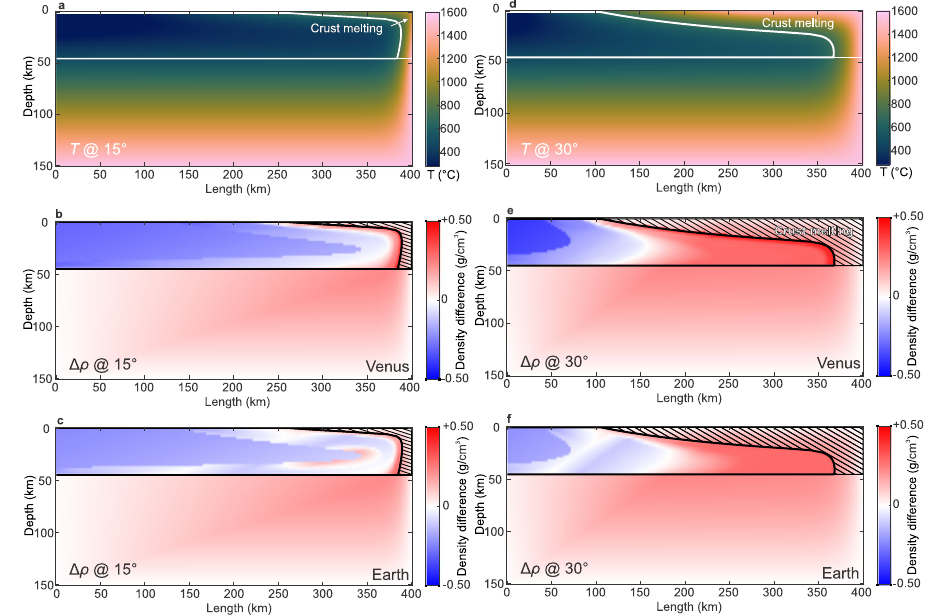
Fig. 3 | Modeled 2-D maps of temperatures and densities of the slabs. a , d Slab temperature pattern, when the submerged slabs rotate to 15° and 30°. Dark and cold colors represent low temperatures, and bright and warm colors represent high temperatures. b , e Paleoproterozoic Earth ’ s slab density pattern, when the submerged slabs rotate to 15° and 30°. c , f Venus ’ (Vega2) slab density pattern,